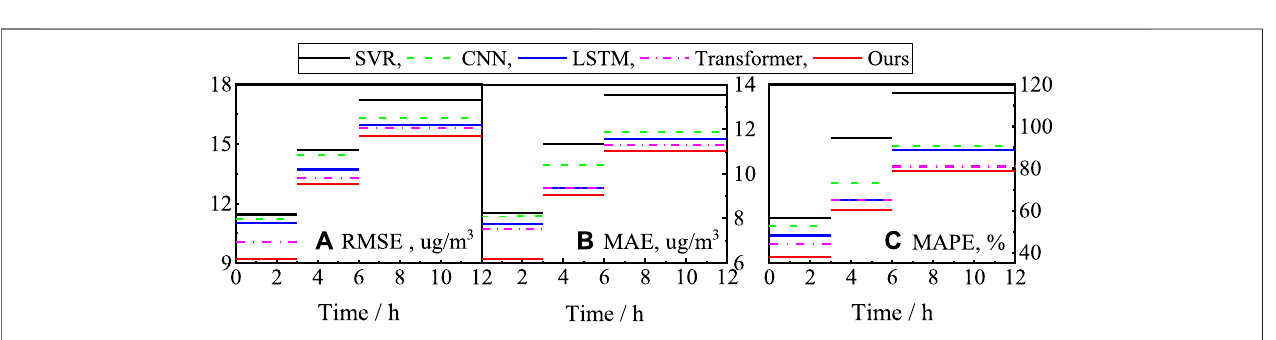
Frontiers in Environmental Science |